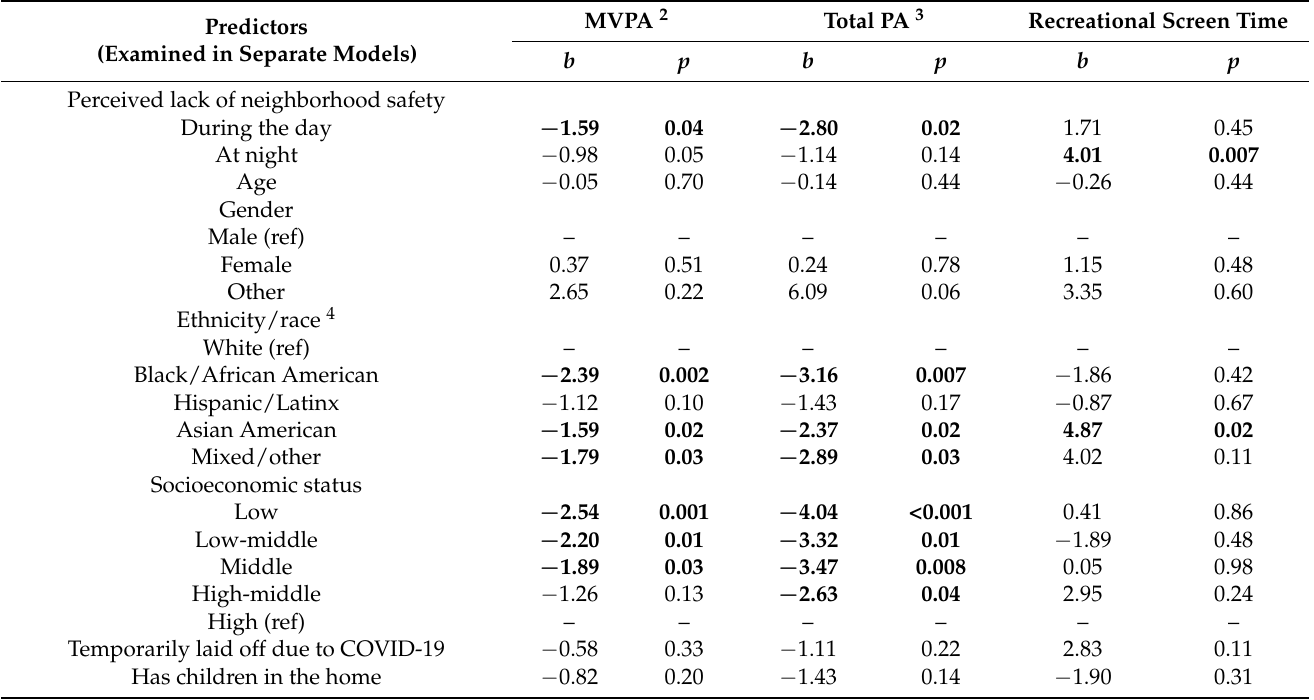
Table 4. Separate Models Examining Predictors of Physical Activity and Recreational Screen Time during COVID-19 Mandatory Stay-at-Home Order 1